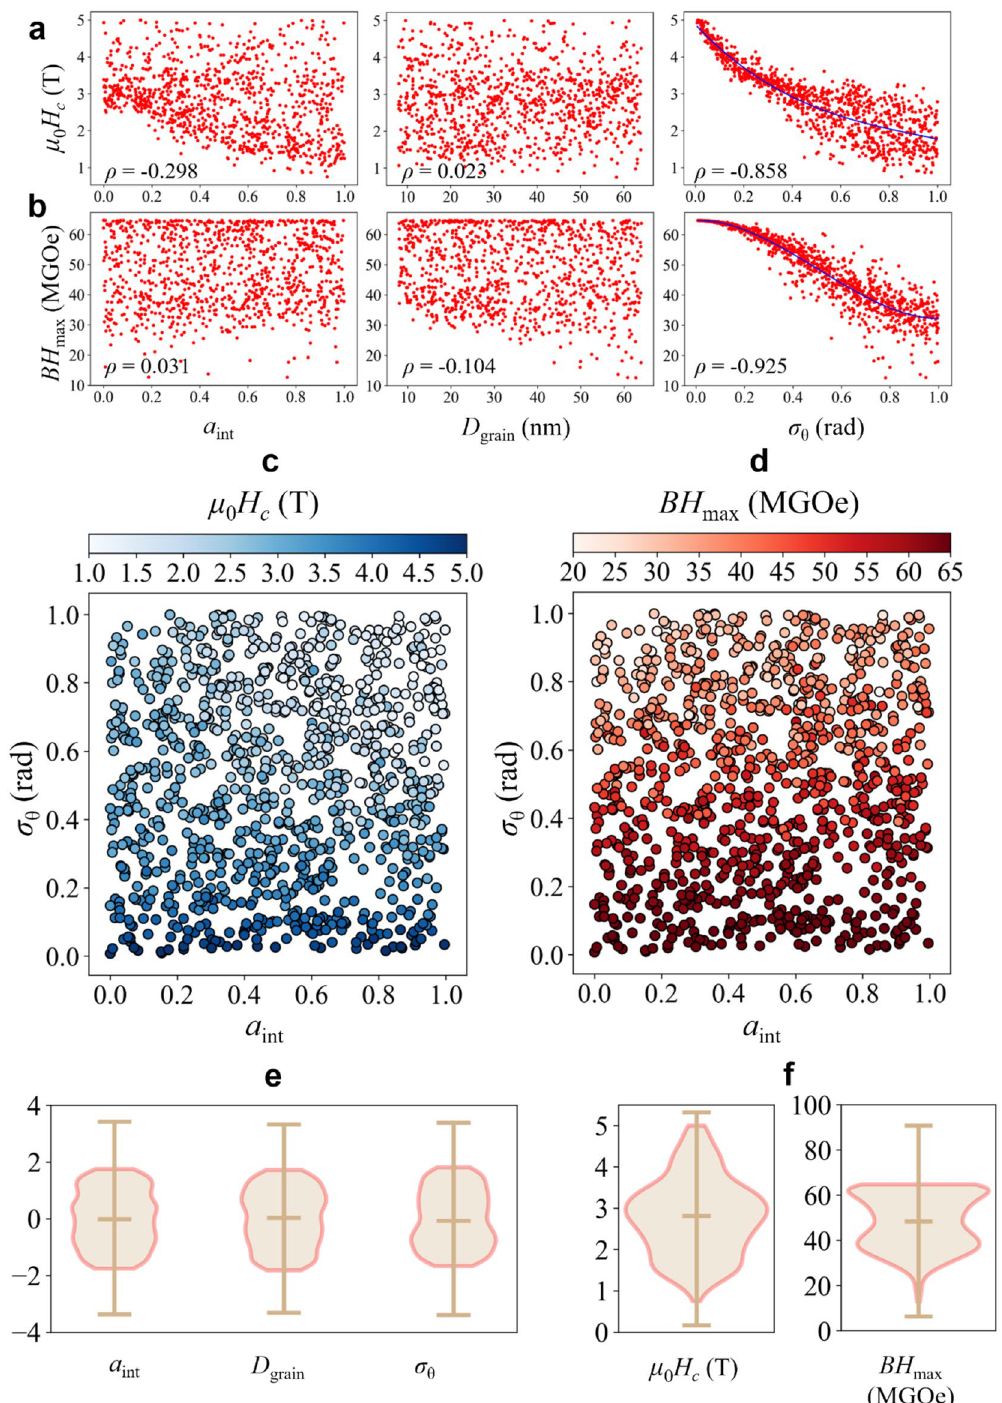
Figure 2. Results of micromagnetic simulations. Scatter plots display the dependence of a int , D grain , and σ θ on (a) coercivity and (b) BH max with the Pearson correlation coefficient ( ρ ) of each plot indicated in the 3 + 5.940 σ 2 − 6.942 σ θ + 4.875 and inset. The expressions for polynomial fits are µ 0 H c ( T ) = − 2.101 σ θ θ BH max ( MGOe ) = − 66.05 σ 3 − 99.98 σ 2 + 1.381 σ θ + 64.78 . In order to investigate the non-linear correlations θ θ between those variables on both coercivity and BH max , scatter plots are displayed with the x -axis indicating a int , the y -axis indicating σ θ , and the color of dots indicating (c) coercivity and (d) BH max . Also, violin plots for (e) z -scores of a int , D grain , and σ θ , and (f) coercivity and BH max are displayed where the outer curves represent the kernel density with the middle line indicating the median. Vertical lines extend and end up in the whiskers, which indicate the lowest and the highest non-outlier